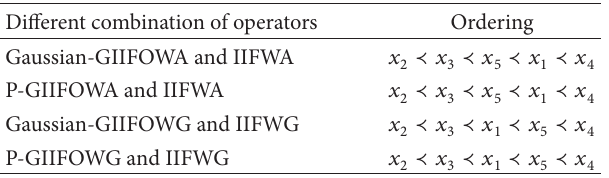
Table 9: Orderings of the alternatives obtained by using different